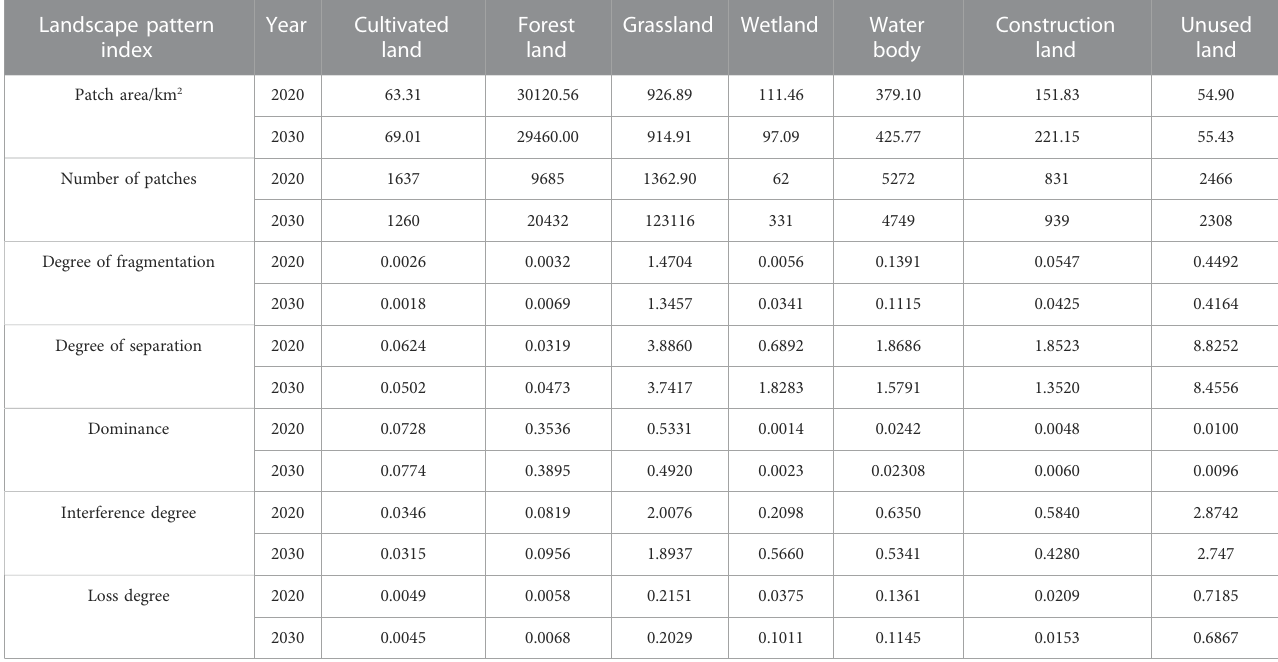
TABLE 6 Comparison of landscape pattern index of Sawan District in 2020 and 2030. Landscape pattern